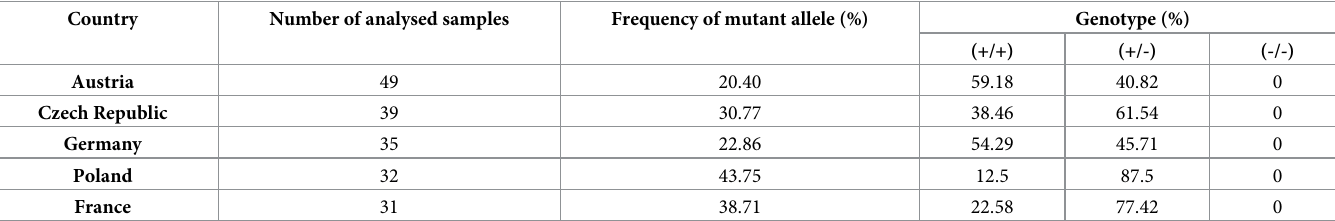
Table 8. Comparison of genotype and mutant allele frequencies in the top five countries for SHT disease. Country Number of analysed